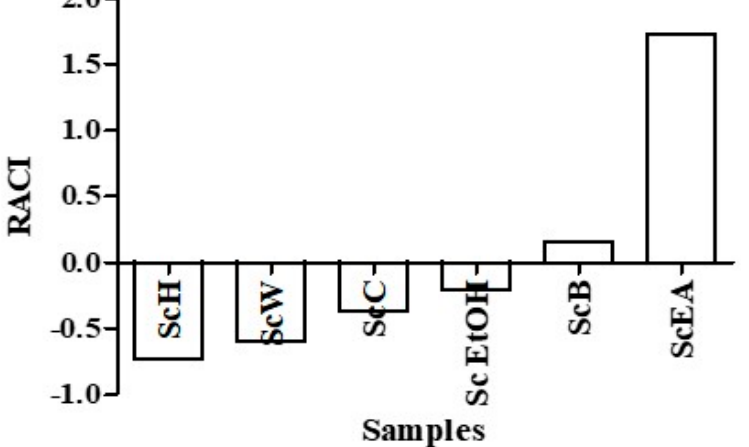
Figure 3. Relative Antioxidant Capacity Index (RACI) of Senecio clivicolus samples. Samples are crude ethanol extract (Sc EtOH), n -hexane fraction (ScH), chloroform fraction (ScC), ethyl acetate fraction (ScEA), n -butanol fraction (ScB), and water fraction (ScW).